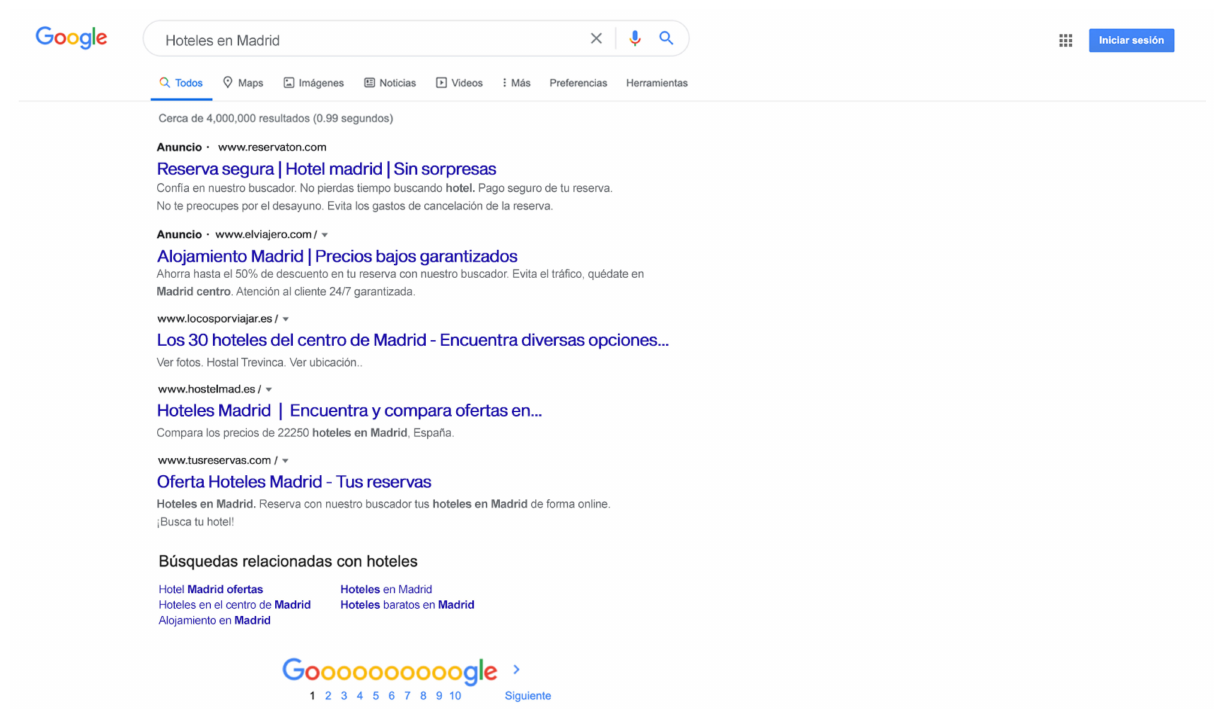
Figure 3. Preventive fit condition